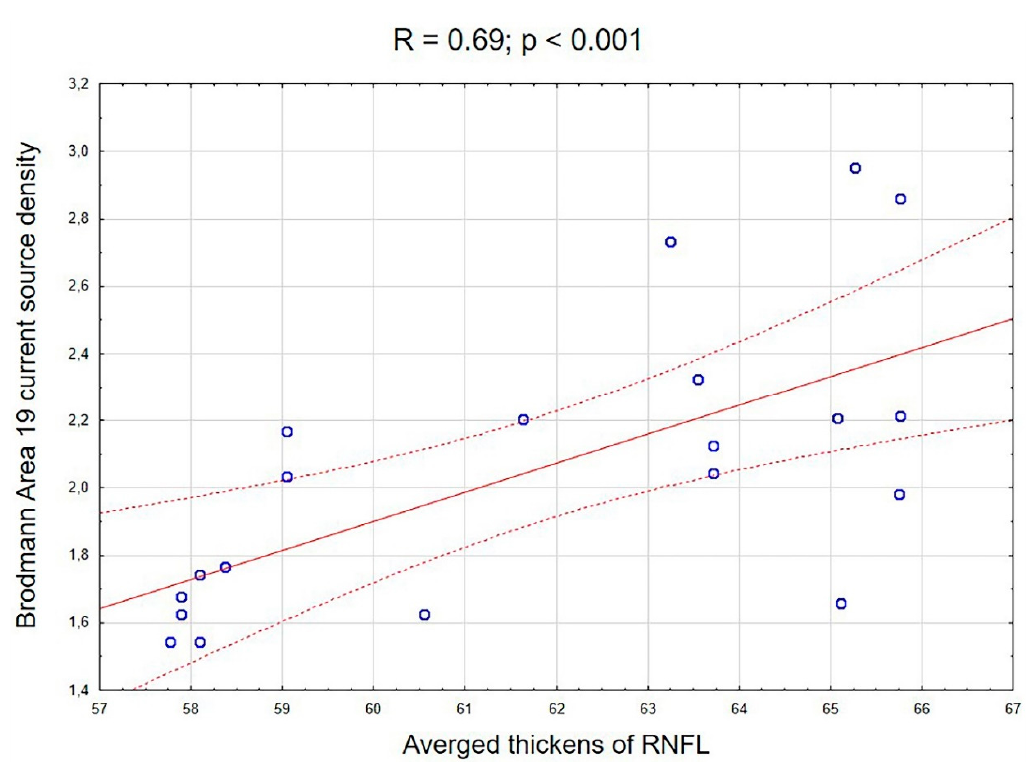
Figure 3. A correlation scatterplot showing the associations between the averaged thickness of the right retinal nerve fiber layer and the right hemisphere BA 19 source signal in the alpha frequency band in the LHON group.